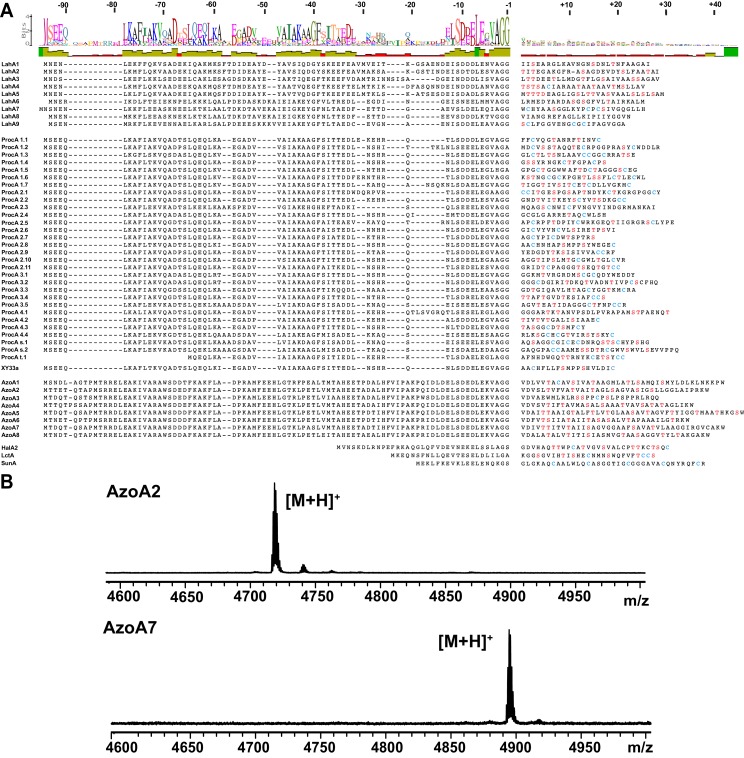
Expanding LahT150 substrate tolerance to non-cognate peptides.(A) MALDI ToF MS analysis of the LahT150-catalyzed cleavage of MBP-tagged-AzoA2 and MBP-tagged-AzoA7. Both peptides have a C-terminal Asp-Ala-His6 added to the native core peptide sequence to improve their ionization; without these tags, the core peptides ionize poorly. Core peptide [M + H]+ masses: AzoA2 (theor 4718.5, obs 4717.7), AzoA7 (theor 4895.6, obs 4894.8). (B) Sequence alignment for LahA, ProcA, XY33a, and AzoA peptides show strong conservation in the C-terminal 12 amino acids of the leader peptide and very divergent core peptides with no detectable homology. LctA, HalA2 and SunA have low homology to all other peptides but are cleaved by LahT150.